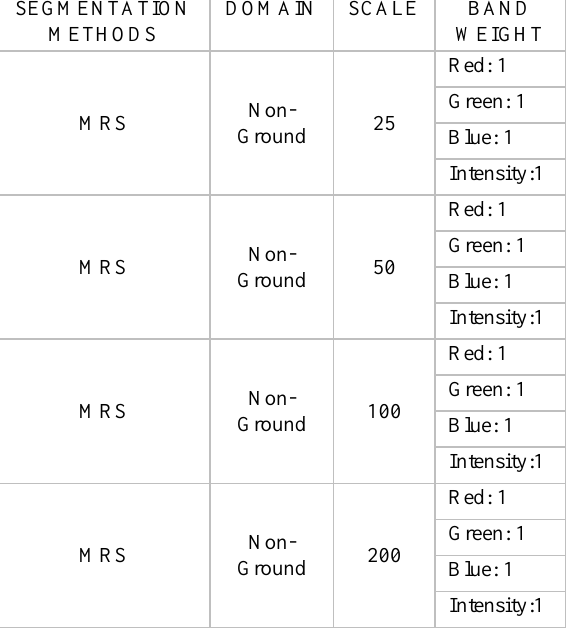
Table 2. Segmentation parameters used for the non-ground